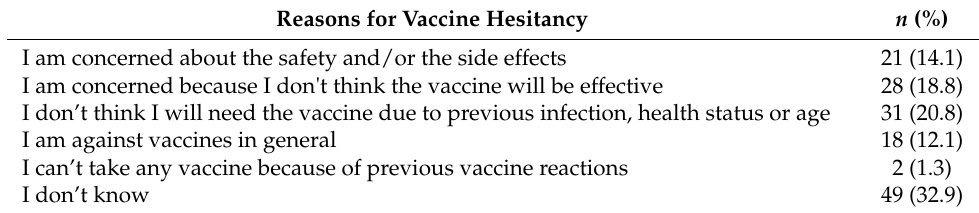
Table 4. Reasons for vaccine hesitancy ( n = 90). Reasons for Vaccine